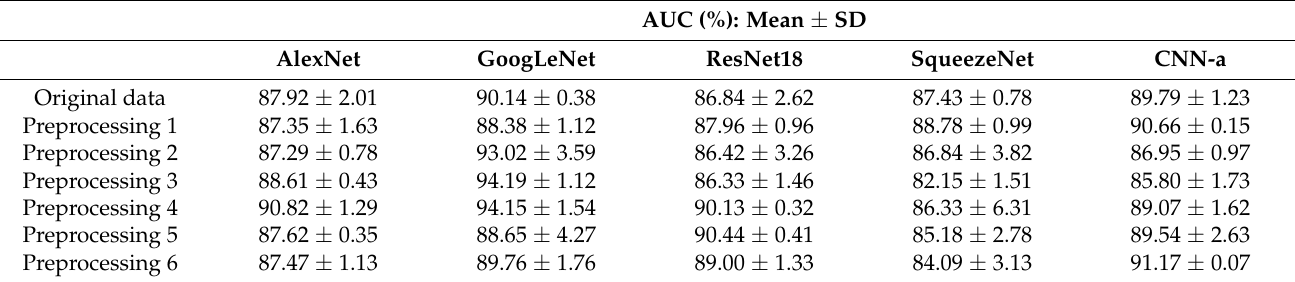
Table 3. Performance results of CNNs trained with original data and with data resulting from the preprocessing methodologies, in terms of mean AUC.